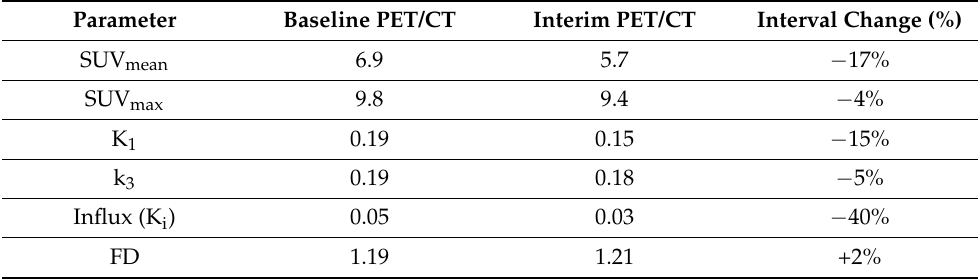
Table 2. Median values of the 18 F-FDG semiquantitative and quantitative parameters before and after two cycles of anti-programmed cell death protein 1 (PD-1) therapy as well as their interval changes (%) as a response to treatment. The values are derived from the mean of the hottest melanoma lesions, up to a maximum of five lesions total for each patient. The units of parameters K 1 , k 3 and influx are 1/min. SUV mean , SUV max and FD have no unit.